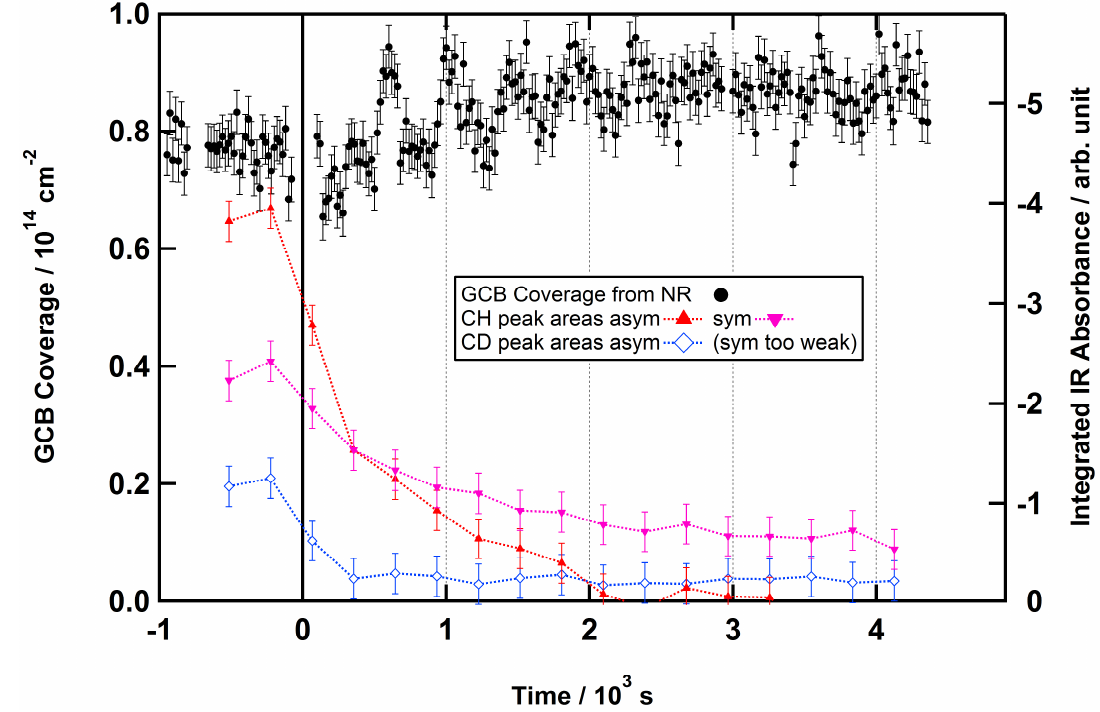
Figure 9. Oxidation of a two component (GCB/POA) monolayer on pure water—NR (black circles and left ordinate) and IRRAS (coloured symbols and right ordinate) data as a function of time. We spread a monolayer of ~6.5 × 10 − 5 L from a spreading solution containing ~0.5 g L − 1 of d -GCB and ~